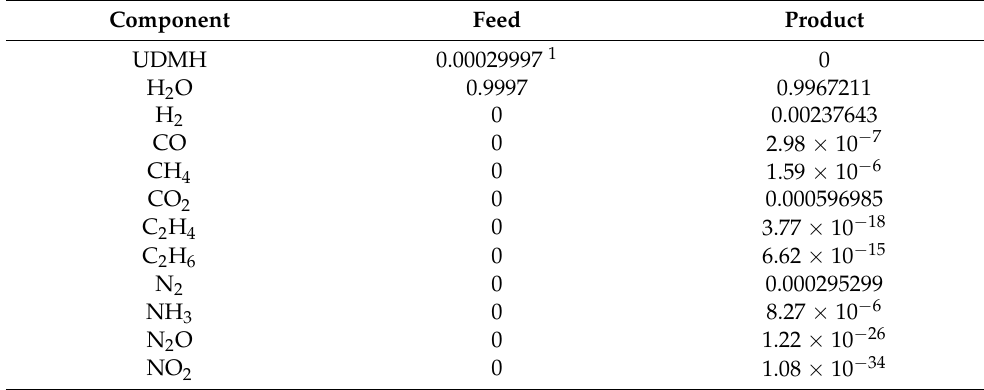
Table 1. Product distribution, calculated by RGIBBS block of ASPEN. Component Feed Product